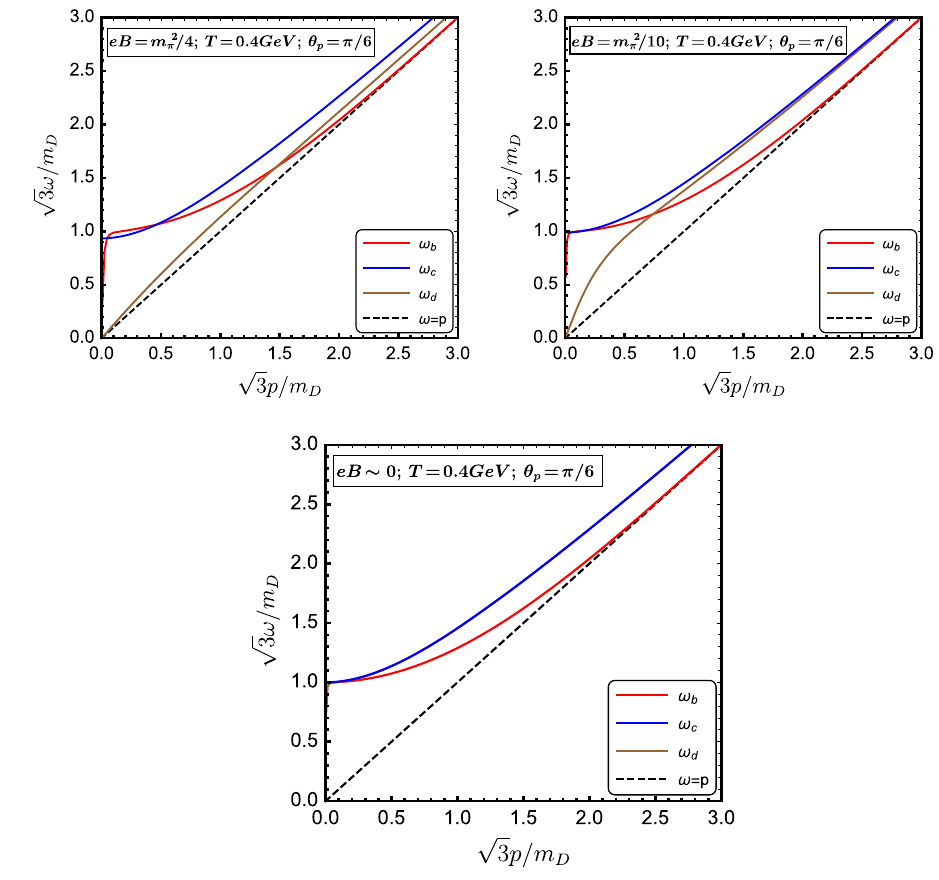
Fig. 7 Gluon dispersion curves for θ p = π/ 6 but with varying magnetic field strength eB = m 2 π / 4 , m 2 π / 10 and m 2 π / 800 ( ∼ 0 ) for N f =